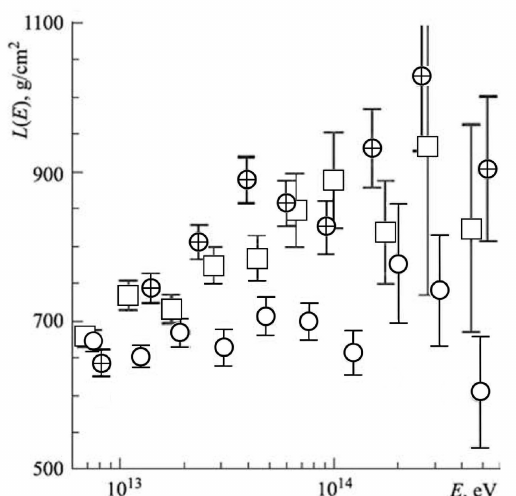
Figure 1. Attenuation length L ( E h ) of hadronic component in EAS cores observed with ionization calorimeter: crossed circles show the experimental data; Monte Carlo simulation results are shown with empty circles ( σ h → c ≈ 0 ) and empty squares ( σ h → c ≈ 0.3 · σ h-nucleus